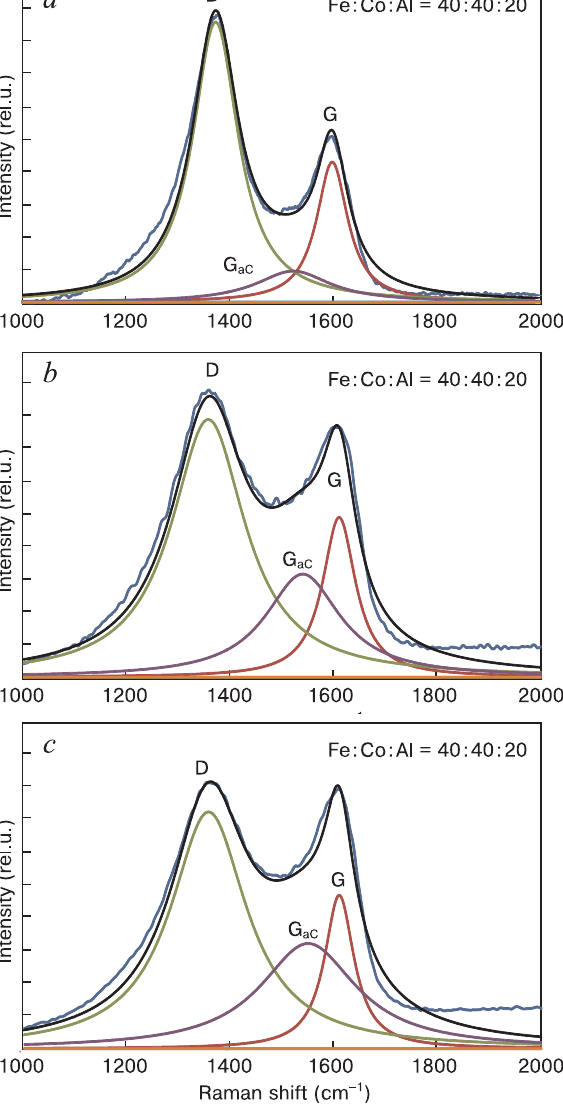
Figure 4. Deconvolution of Raman spectra of FeCoAl/С nano - composites sytnthesized at different temperatures (°C): ( а ) 500; ( b ) 600; ( c )